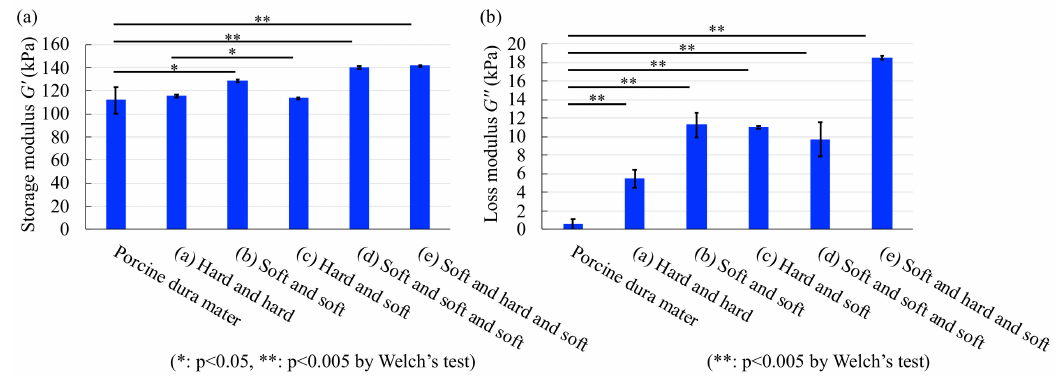
Figure 6. Measured viscoelastic results: ( a ) Storage modulus of porcine dura-mater and each dura-mater model; ( b ) Loss modulus of porcine dura-mater and each dura-mater